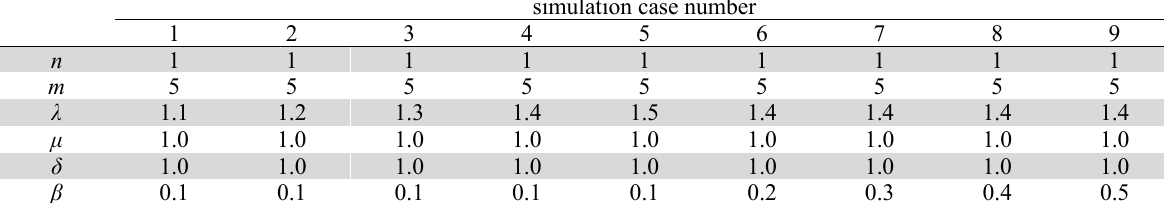
Parameters for simulation cases 1 – 9. The definition of the symbols is given in Table